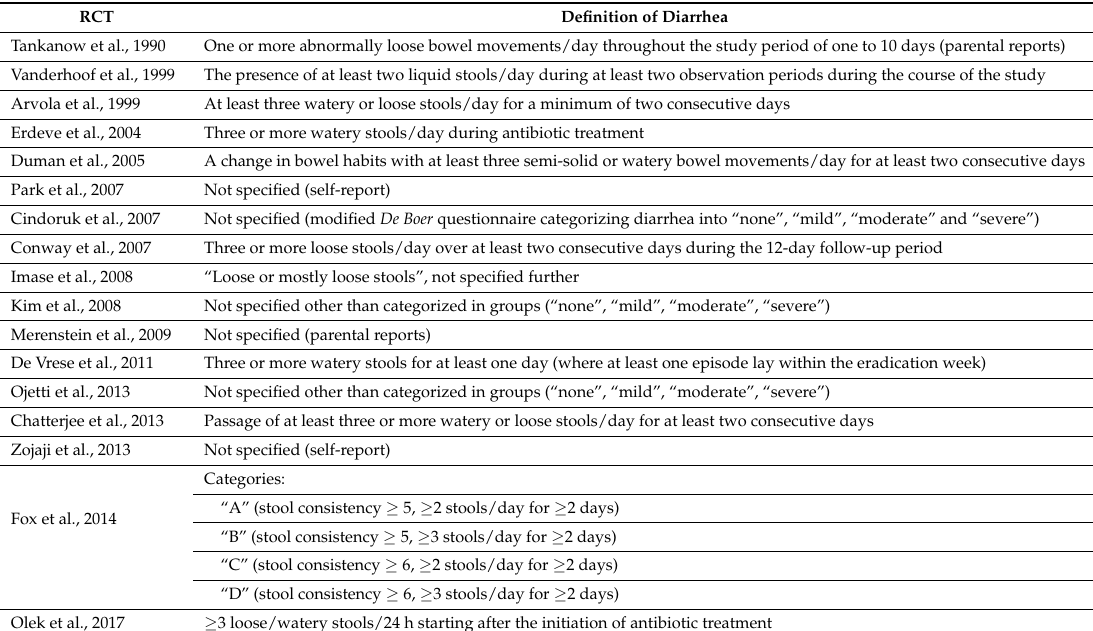
Table 2. The individual studies’ definitions of